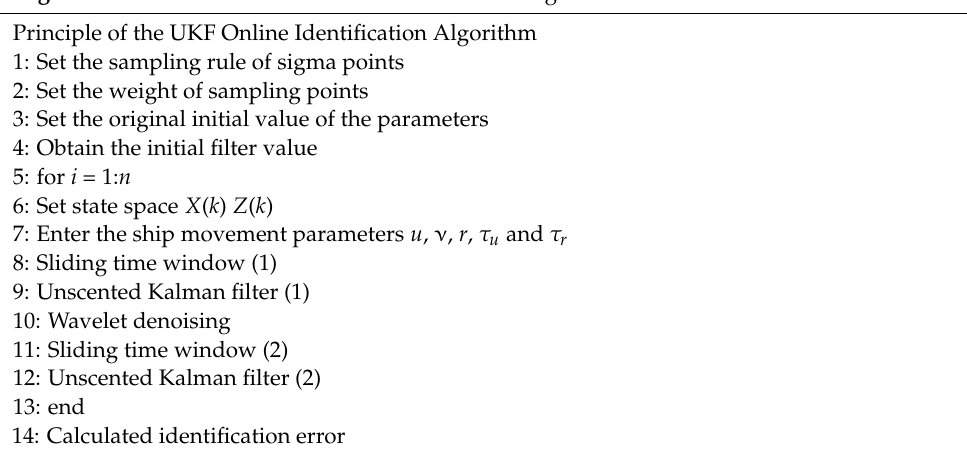
Algorithm 1 Unscented Kalman filter identification